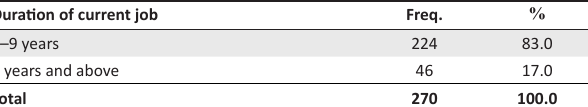
TABLE 1f: Background of respondents.